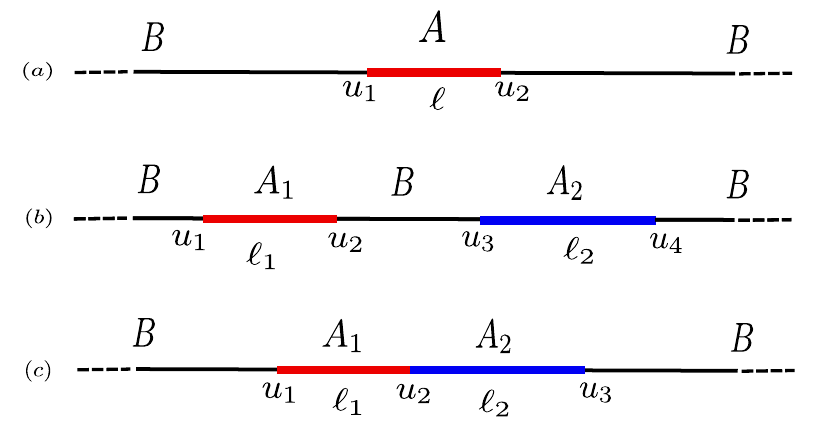
Figure 1 . Configuration of a (a) single interval (top), (b) two disjoint intervals (middle), and (c) two adjacent intervals (bottom) in a (1 + 1)-dimensional CFT